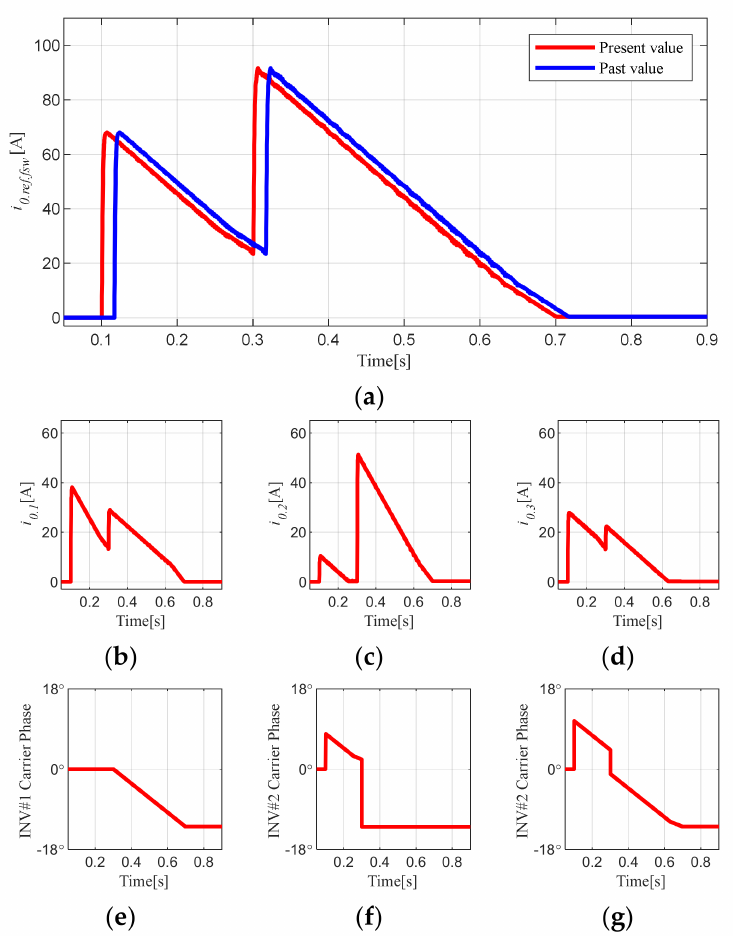
Figure 12. Result of simulation of control for phase error occurring during control operation 2 ( a ) trend of reference zero − sequence current, ( b ) trend of zero − sequence current of inverter 1, ( c ) trend of zero − sequence current of inverter 2, ( d ) trend of zero − sequence current of inverter 3, ( e ) carrier phase of inverter 1, ( f ) carrier phase of inverter 2, ( g ) carrier phase of inverter